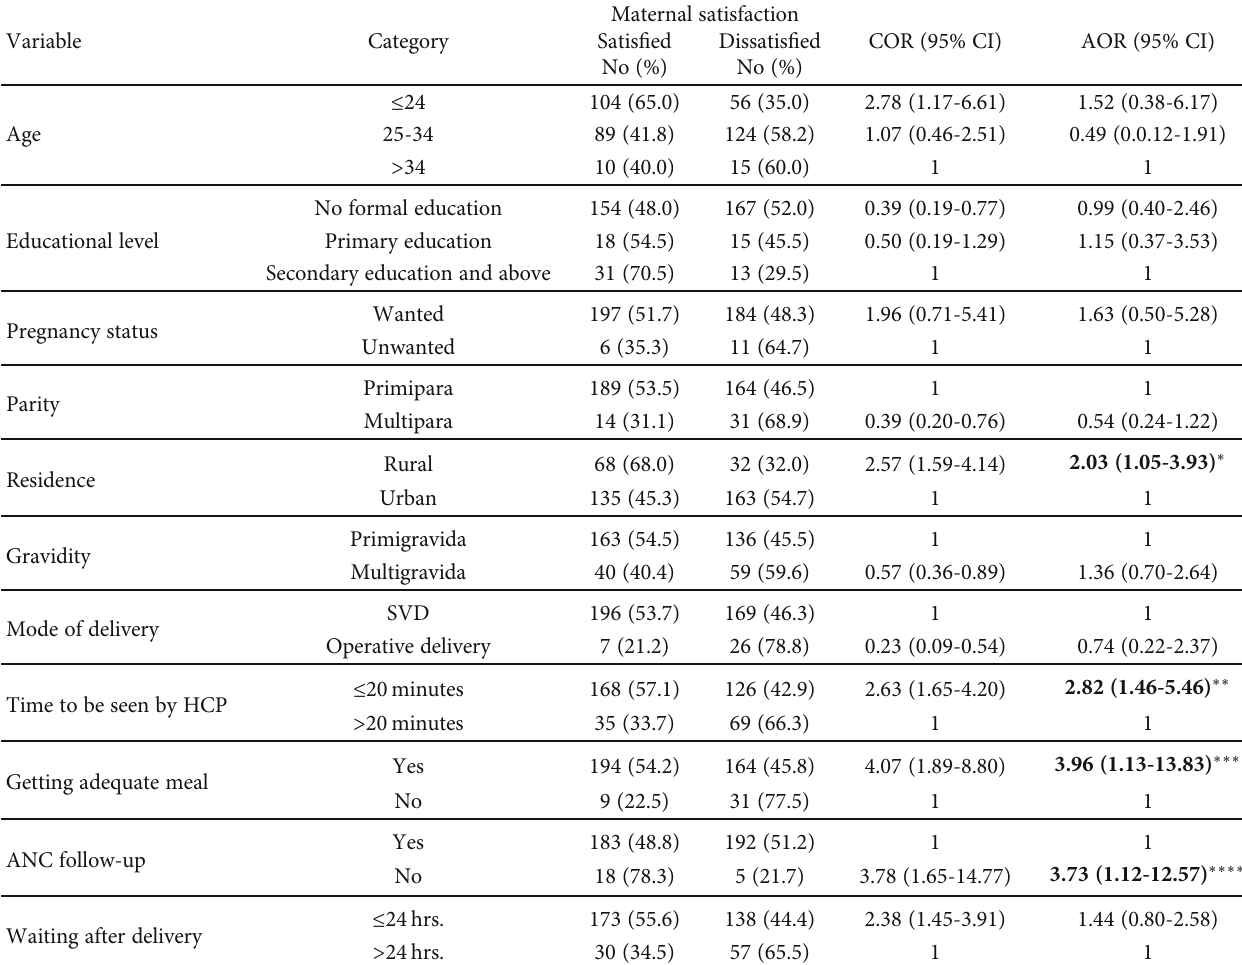
Table 3: Factors associated with maternal satisfaction with intrapartum care among mothers who gave birth at a public hospital in North Wollo Zone, 2019 ( n = 398